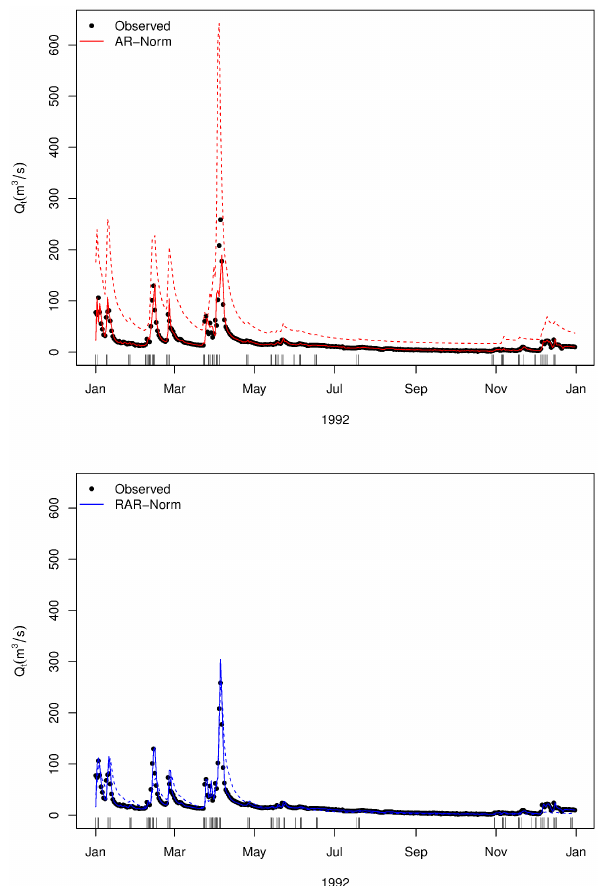
Figure 4. Forecast streamflows for the Orara catchment for an ex- ample 1 year period. The top panel shows streamflows forecast with the AR-Norm model; the bottom panel shows streamflows forecast with the RAR-Norm model. Dashed lines: forecasts from the base hydrological model (i.e. without error updating). Solid lines: fore- casts with error updating. Tick marks on the x axis denote the in- (cid:12) (cid:12) stance of updating where D t > (cid:12) Q t − 1 − e Q t − 1 (cid:12) .